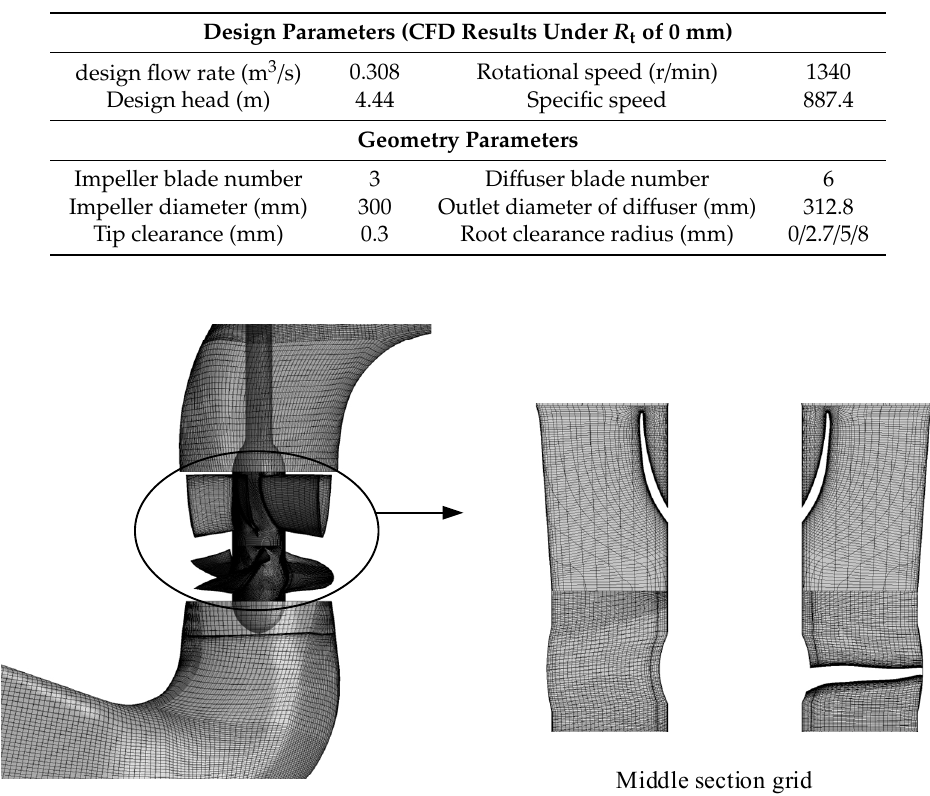
Figure 2. Mesh of axial flow pump device.